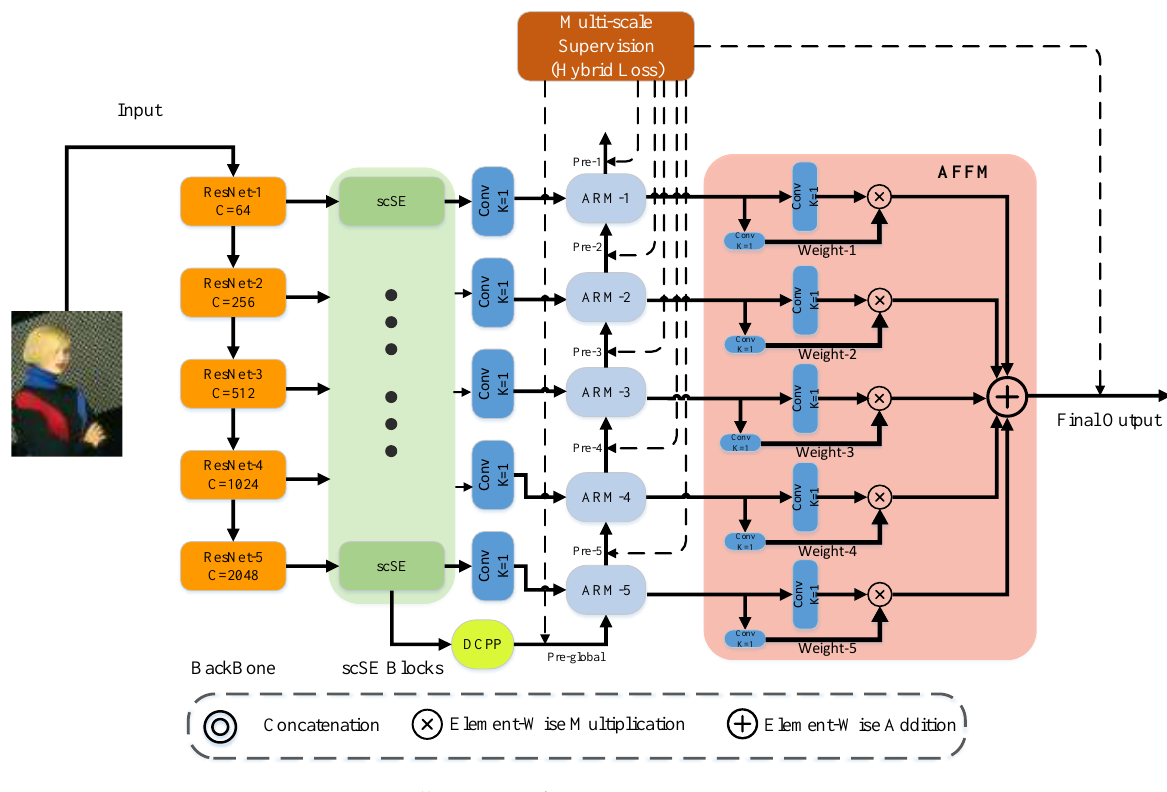
Figure 1. Illustration of FRNet.